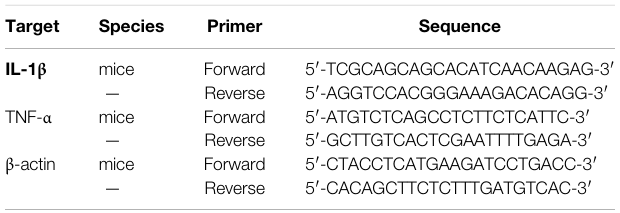
TABLE 1 | Primers for reverse transcription-quantitative polymerase chain reaction. Target